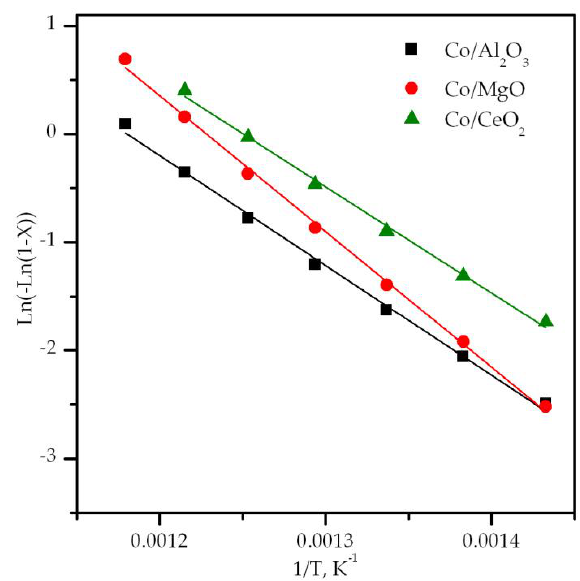
Figure 9. Order integral fit for the experimental kinetic data obtained over the supported cobalt catalysts.